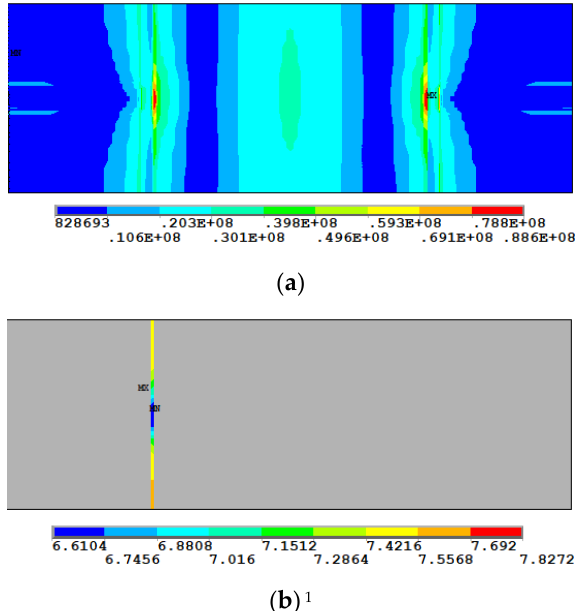
Figure 9. Mises stress of the bottom side of the bridge deck of a traditional weld seam. ( a ) Mises stress diagram of the bottom side of the bridge deck (Pa). ( b ) Fatigue cyclic life of the connection of the rib-to-deck, 1 the number in the contours is the base 10 log of the contour line.